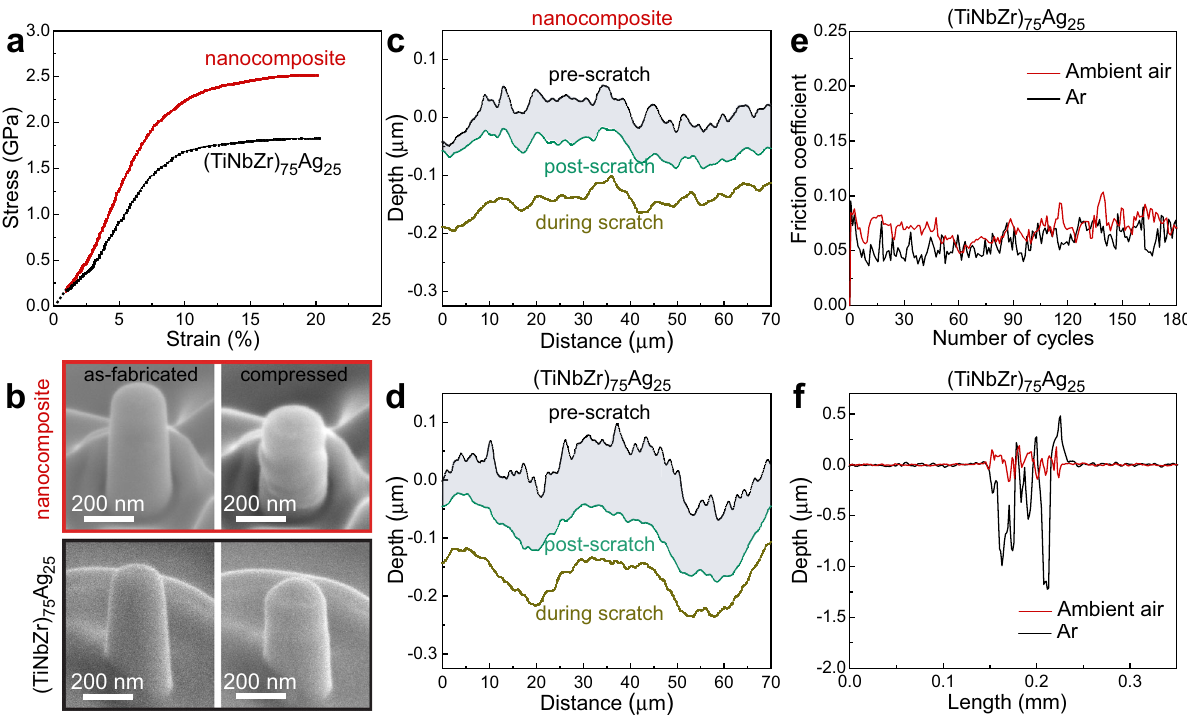
Fig. 4 Effect of the amorphous-crystalline nanocomposite on wear reduction. a Typical compressive engineering stress-strain curves obtained for the 200-nm-diameter nanopillars of the nanocomposite and of the as-deposited (TiNbZr) 75 Ag 25 alloy. b SEM images of the nanocomposite and the (TiNbZr) 75 Ag 25 alloy nanopillars before and after compression. c , d Surface pro fi les as a function of scratch distance for the nanocomposite and (TiNbZr) 75 Ag 25 alloy. e Friction coef fi cients of the (TiNbZr) 75 Ag 25 alloy sliding against 4-mm-diameter stainless steel ball in Ar atmosphere and ambient air, respectively. f The corresponding 2D cross-sectional pro fi les of the wear